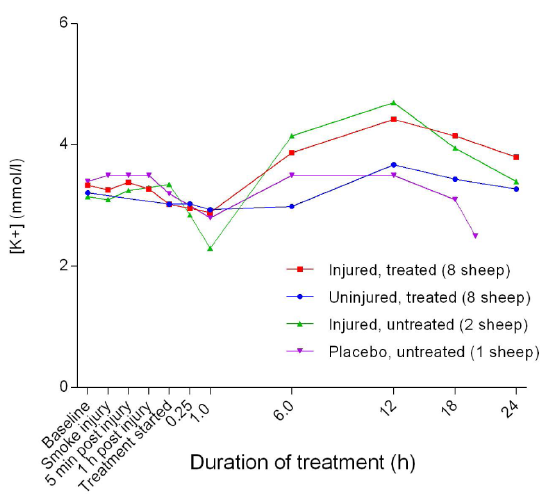
Figure 16. Concentration of potassium ions in blood (Mean ± SD, error bars not shown) in smoke and non-smoke injured sheep that received extracorporeal life support as compared to that in untreated controls. Error bars have been omitted for clarity.